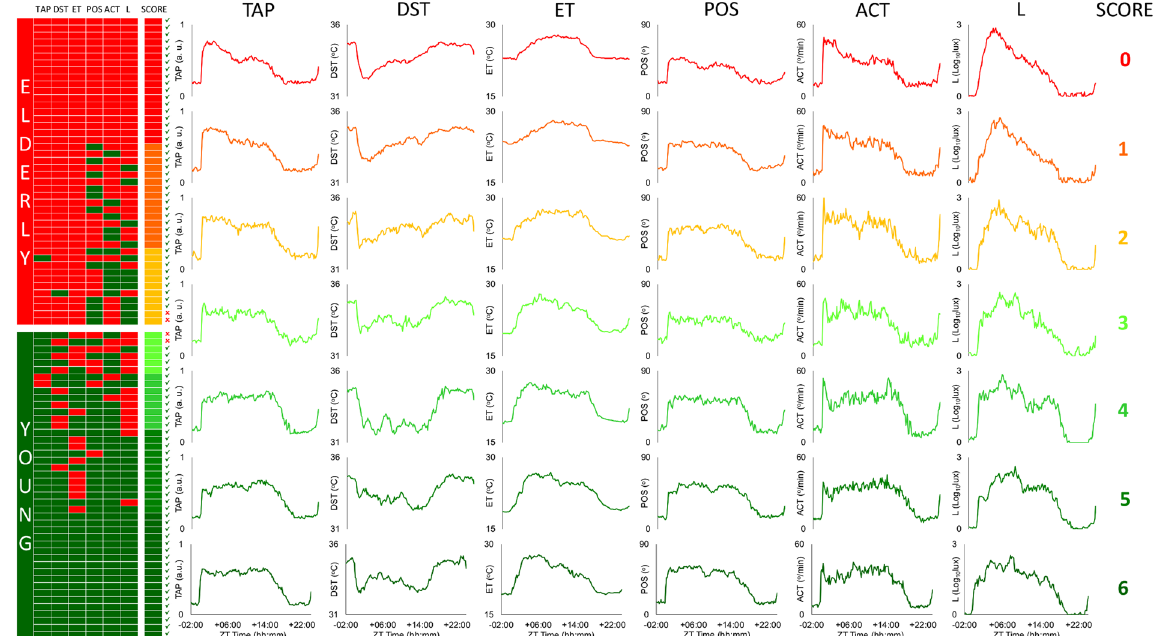
Figure 5. Macroarrays according to global score and agreement rates. Each row represents one participant, ordered by global score from top to bottom (from low to high scores, respectively). Rhythmic variables are ordered from left to right, according to their agreement rate for predicting age (TAP, DST, ET, POS, ACT and L). A red cell indicates that the subject was classified as aged, while a green cell indicates that the subject was classified as young. A global score column (again in a gradient from red to green), as well as a green checkmark (correct global classification) or a red cross (incorrect global classification), are shown following the variable columns. Next to the macroarrays, sleep offset standardized mean waveforms for each punctuation in the global score are represented and ordered from left to right, according to their agreement rate for predicting age and from top to bottom, as scores increased (as described above).